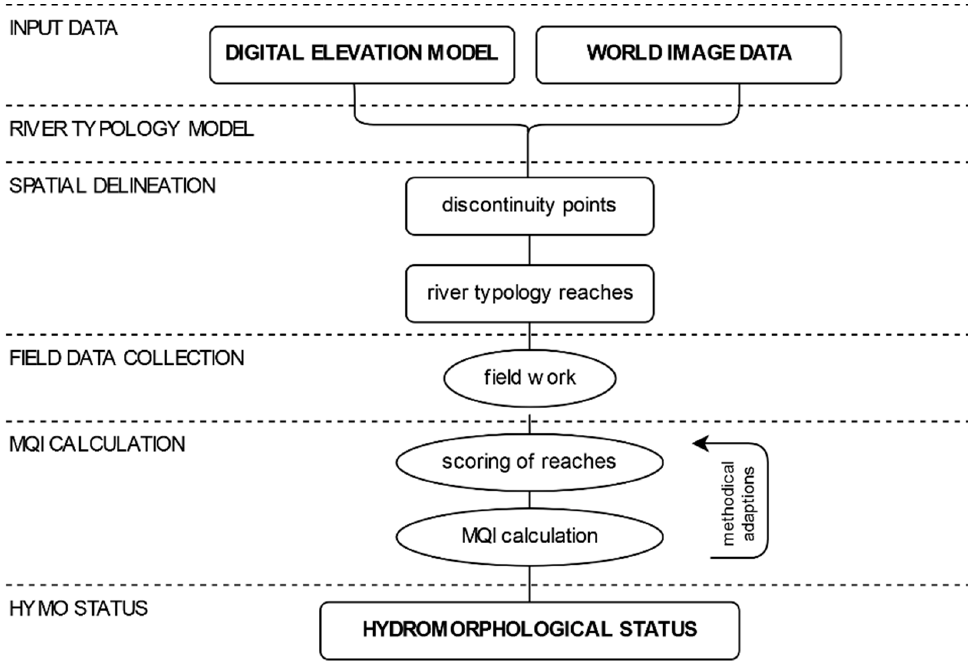
Figure 2. Workflow of the method used within this study in several steps: The methodical approach was built on DEM and world image data, the river system was delineated into reaches. Field observations created the source of data for the assessment with an adapted version of MQI. As a result, the hydromorphological status quo was classified.